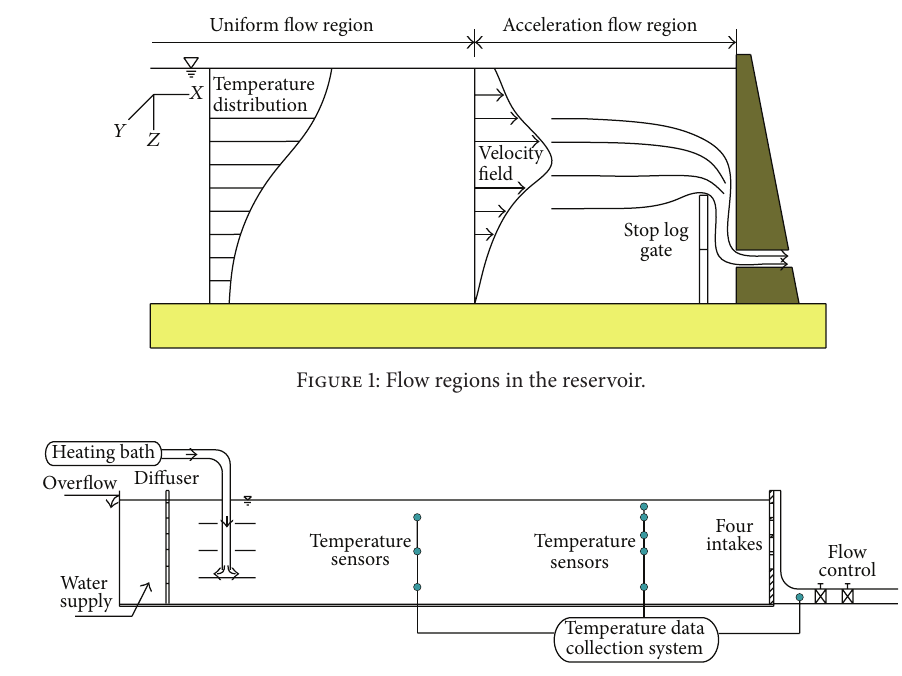
Figure 2: Schematics of selective withdrawal using stop log